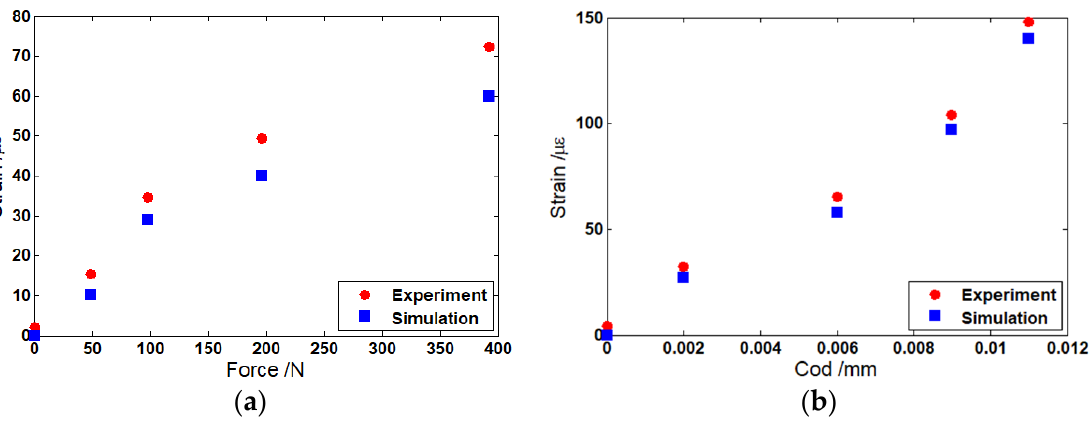
Figure 4. Strain curves with ( a ) theoretical and ( b ) experimental results for COD = 0.002 mm, 0.006 mm, 0.009 mm, and 0.011 mm.